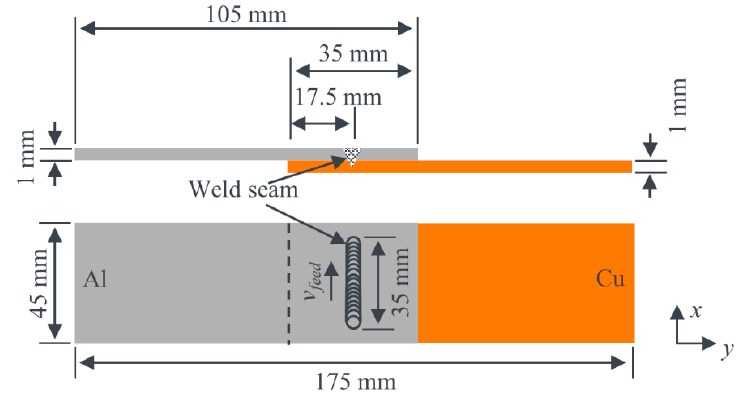
Figure 1. Sketch of the geometry of the specimens used for the welding trials and shear tests.